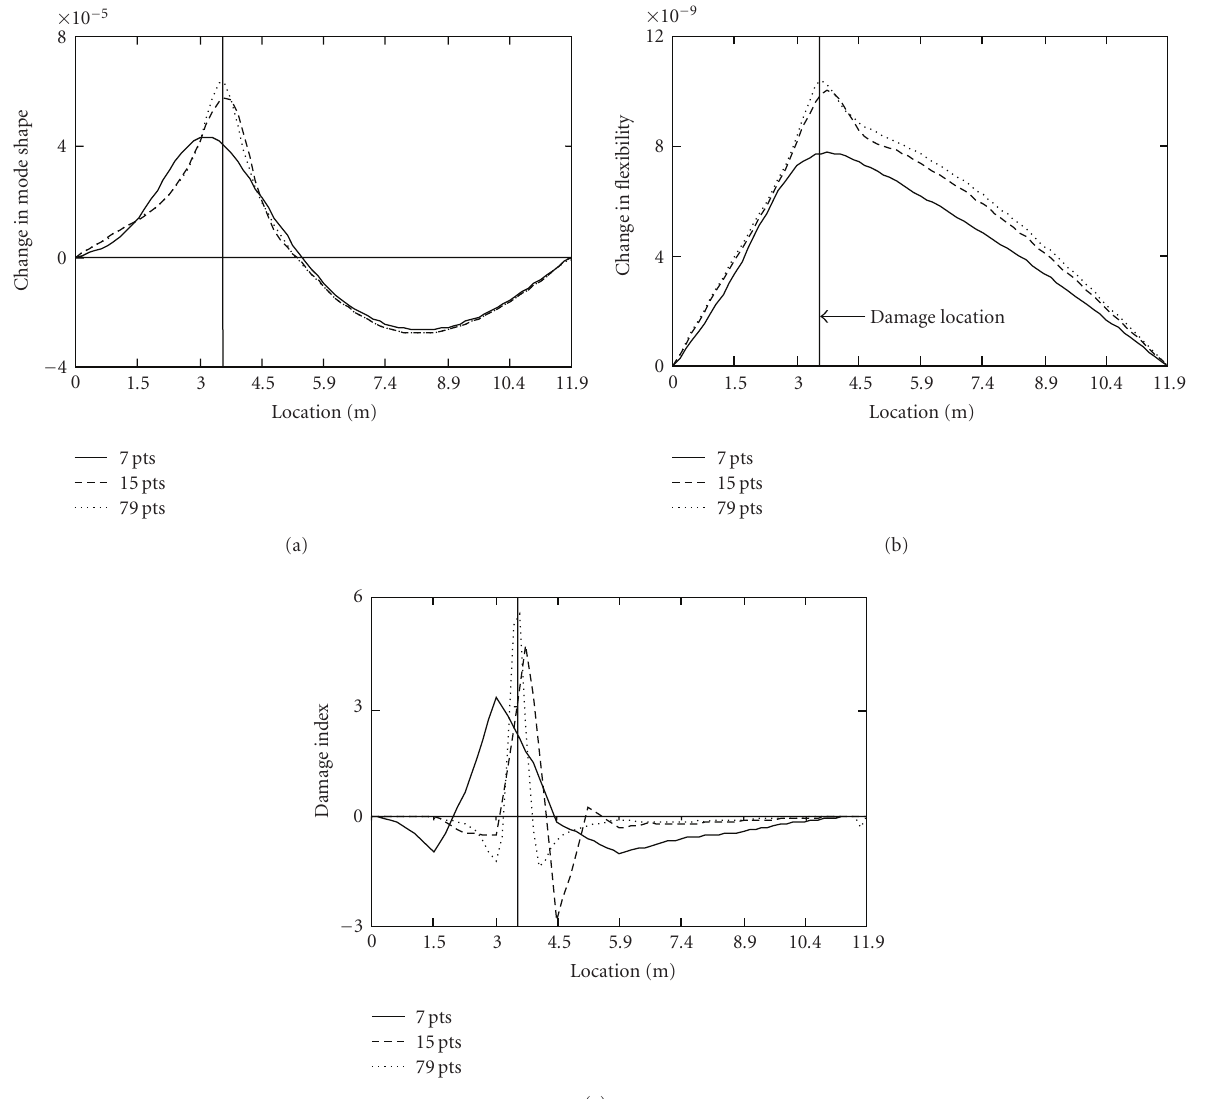
Figure 10: Comparison of VBDD parameter distributions for numerical damage case 24, obtained using 7, 15, and 79 measurement points for (a) the CMS, (b) MCF, and (c) DI methods. Labels along the location axis correspond to the seven measurement